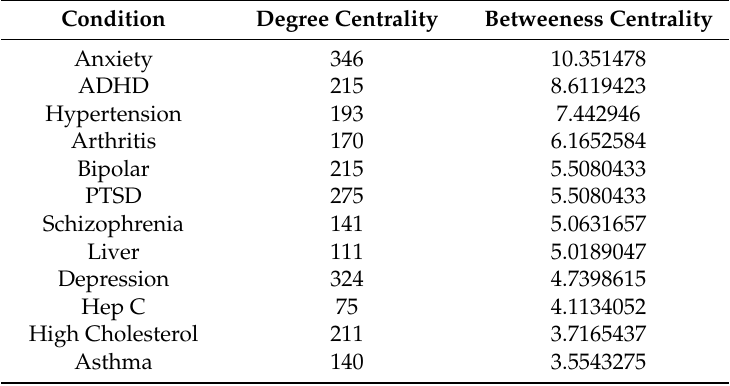
Table 5. Centrality Measures for Comorbidity